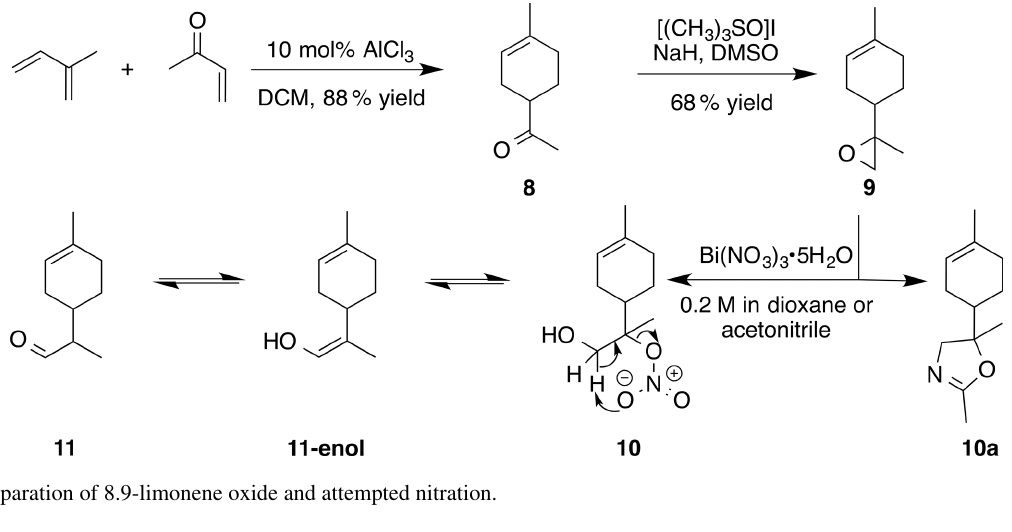
Figure 4. Preparation of 8.9-limonene oxide and attempted nitration.